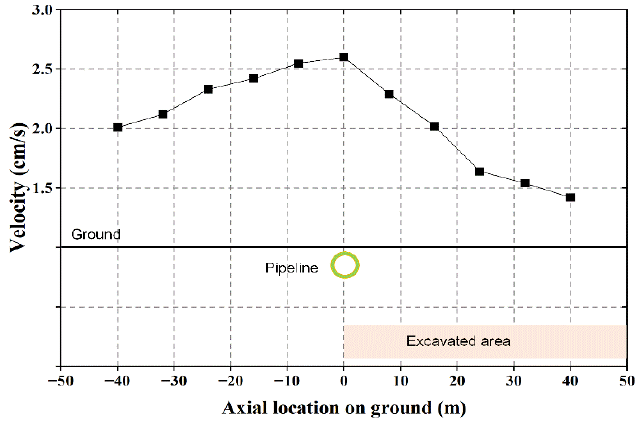
Figure 10. Distribution of the axial surface soil’s